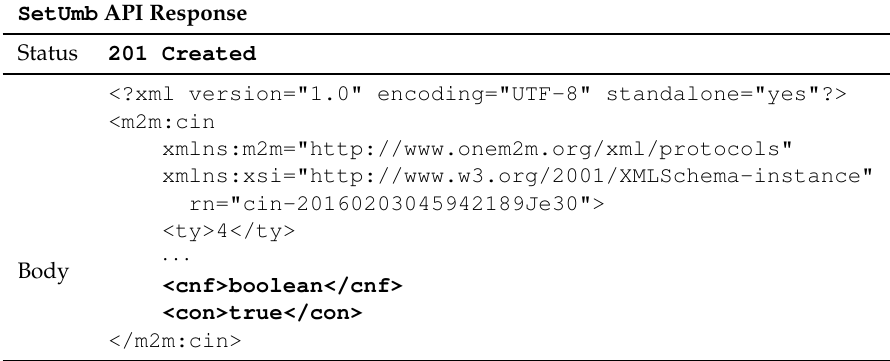
Table 6. An example of the SetUmb API response showing that a new resource ( i.e. , control value) was created